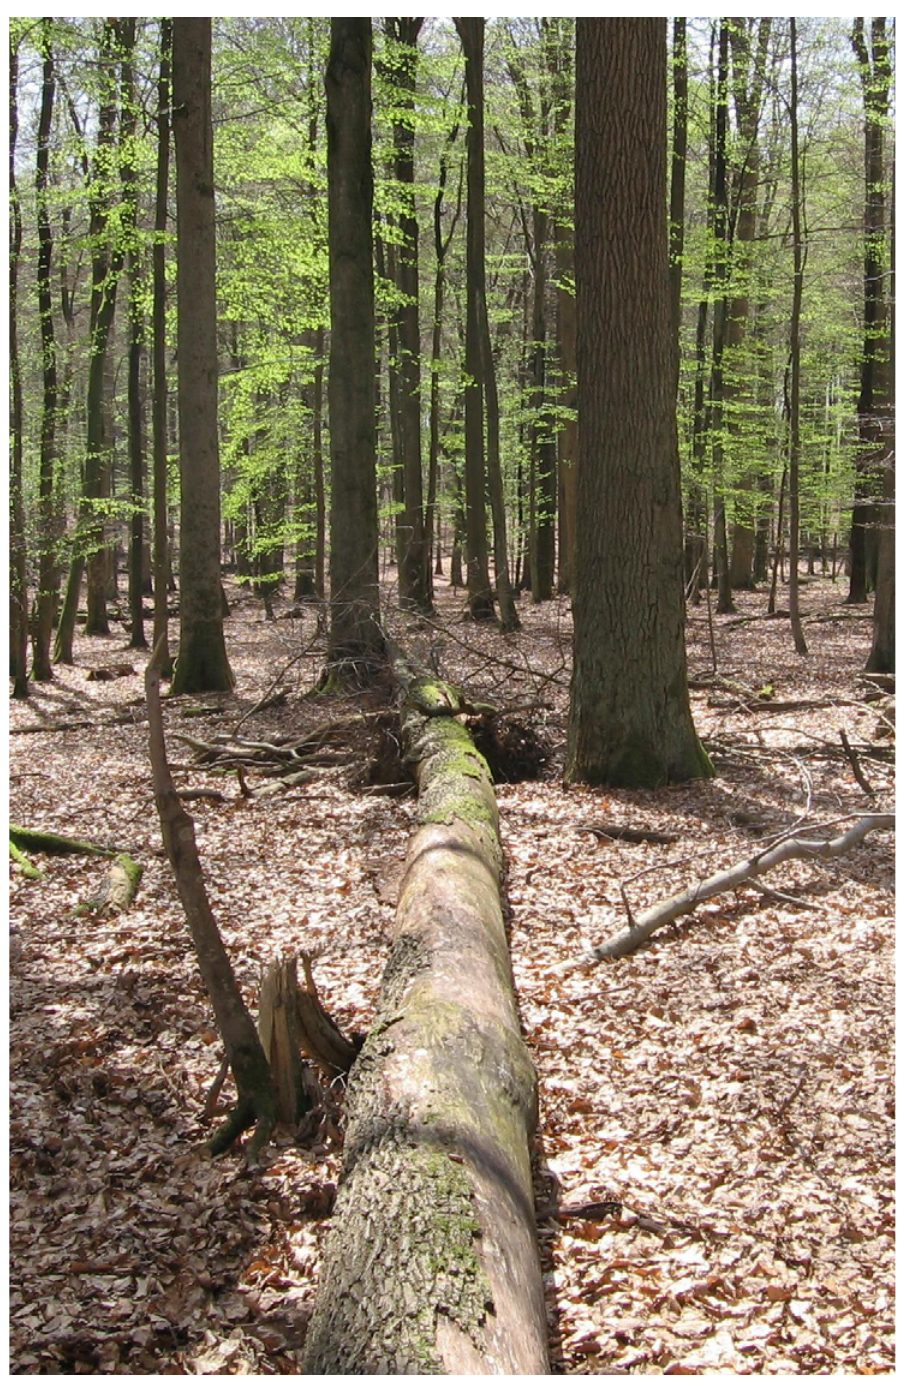
Fig. 2. The site of Xylobolus frustulatus occurrence (photo J.